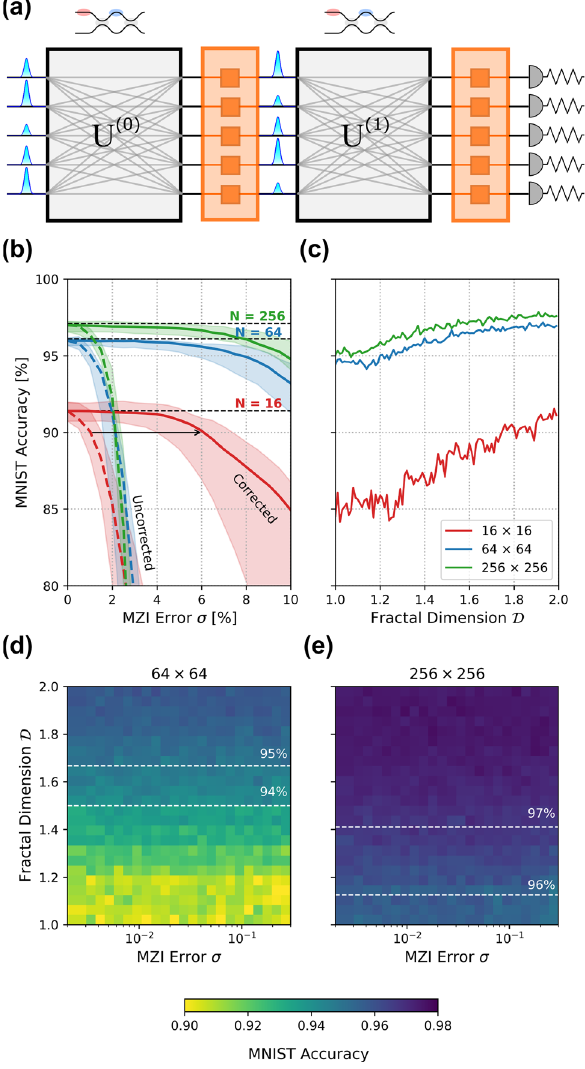
Figure 6: Performance of optical neural networks (ONNs) constructed using SCF meshes. (a) 2-Layer deep neural network architecture for MNIST classification where the blocks U (0 , 1) represent unitary transforms by the sine–cosine fractal mesh. (b) Simulated classification accuracy as a function of mesh size ( N = 64 and 256) and MZI error 𝜎 . (c) Classification accuracy as a function of degree of pruning  ∈ [1 , 2] and mesh size ( N = 16 and 64 and 256). (d) and (e) Classification accuracy as a function of the degree of pruning  and MZI error, trained on maximally faulty mesh of size N = 64 and